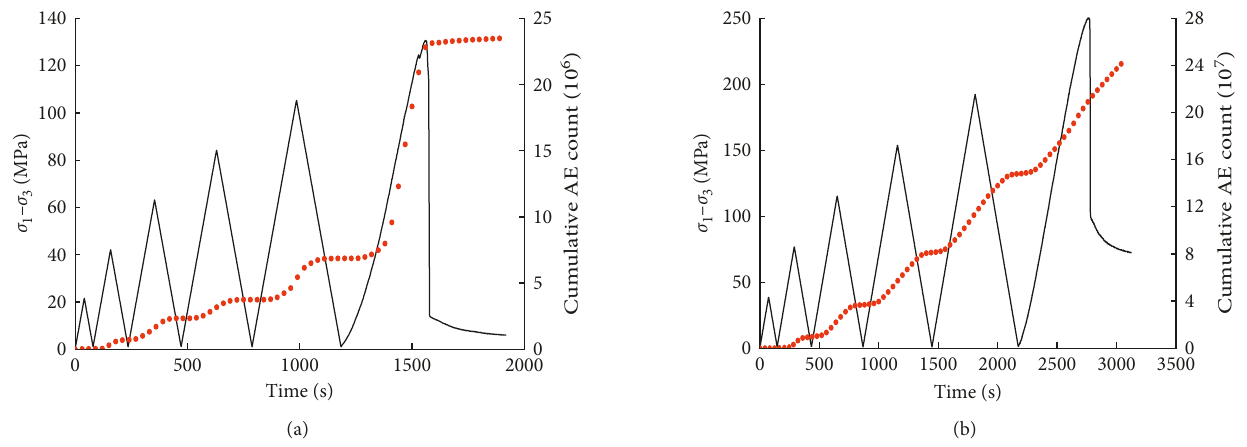
Figure 2: Time history curves of stress and cumulative AE count of samples under cyclic loading. (a) σ